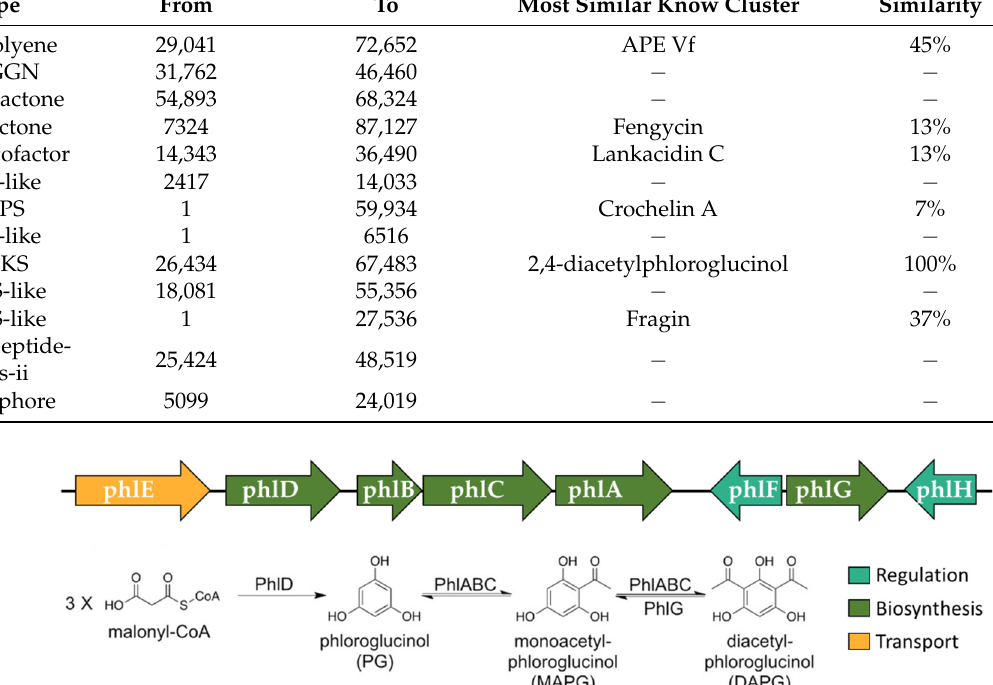
Figure 3. Genes involved in the 2,4-diacetylphloroglucinol pathway reported in the genome of Pseudomonas sp. strain C3.